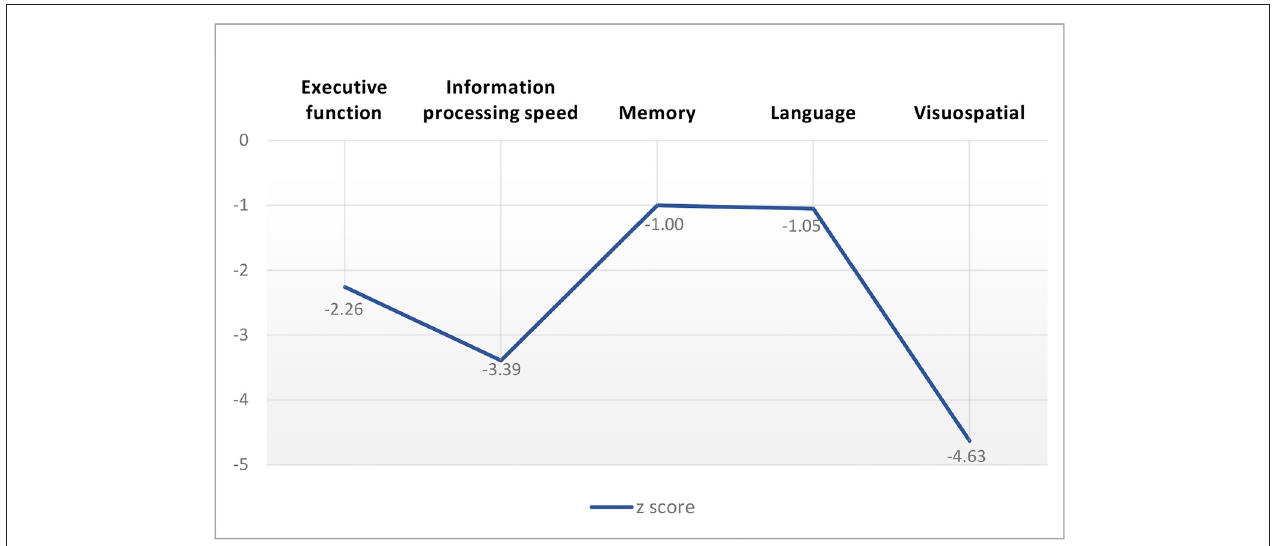
FIGURE 3 | Cognitive performance profile of patients with CADASIL according to z score of cognition measures.